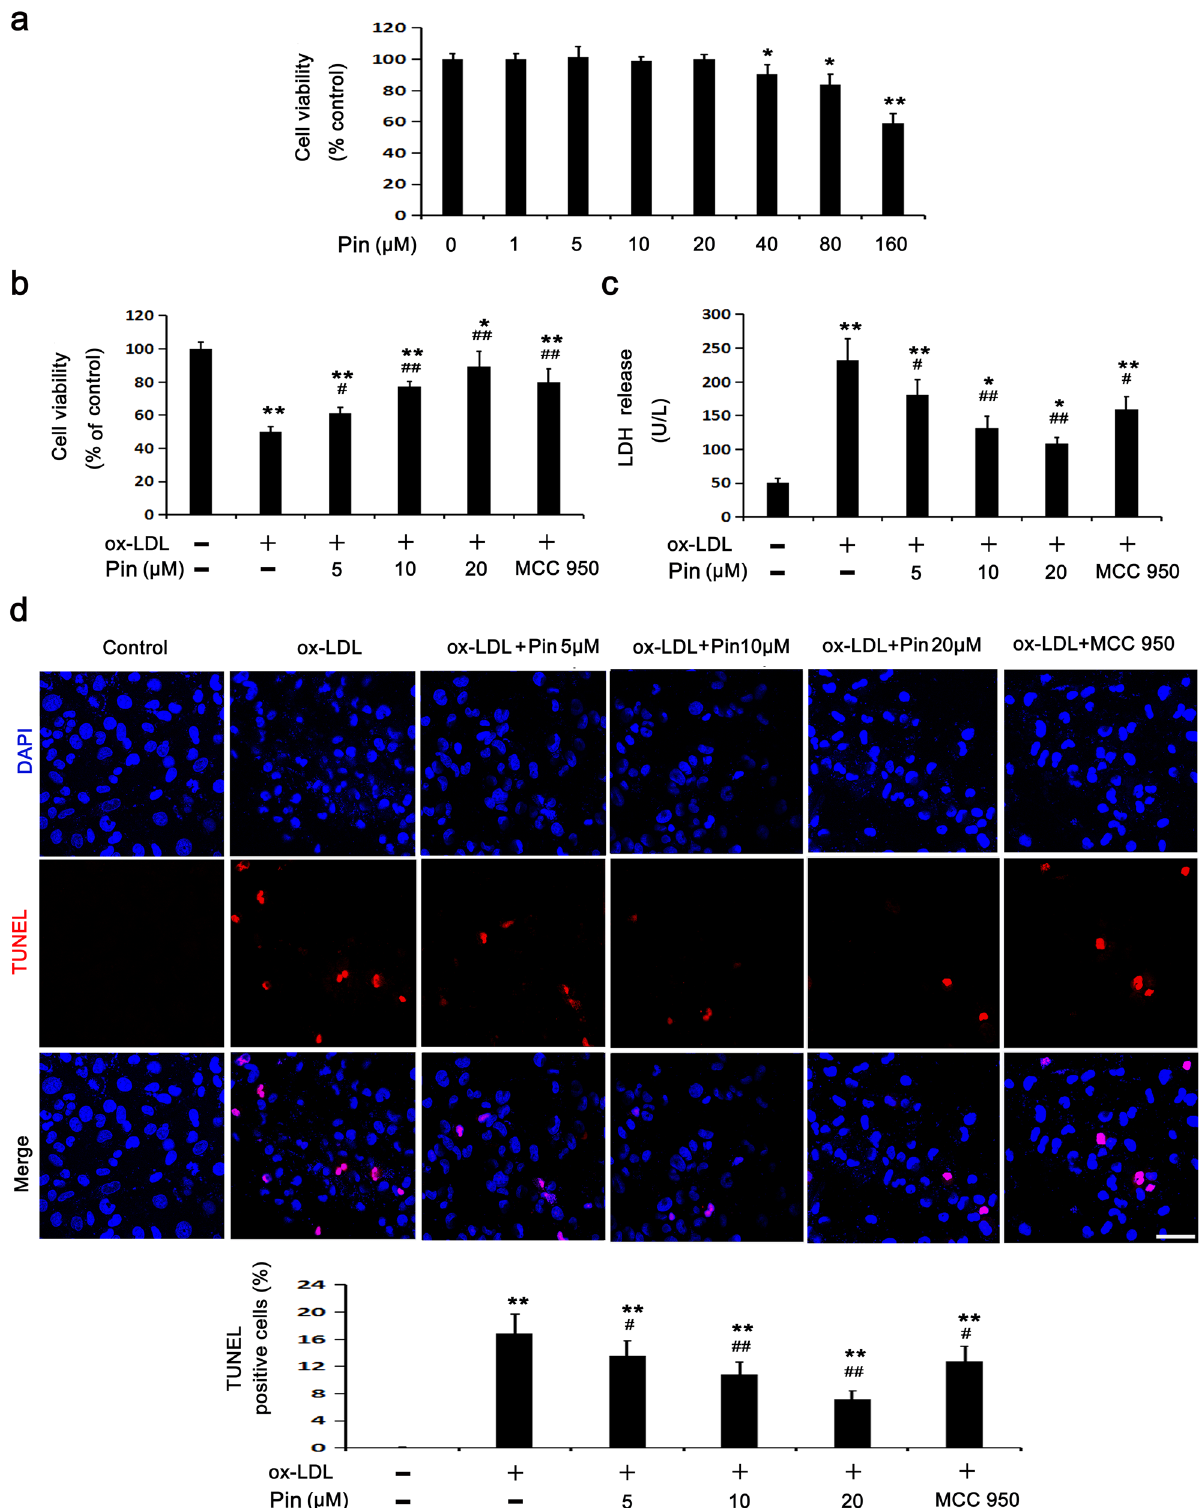
Figure 2. Role of Pin in oxLDL-challenged HUVECs. HUVECs were incubated with Pin (0–160 μM) for 24 h. ( a ) Cell viability was detected through the CCK8 assay. Cells were pretreated with Pin (5, 10, 20 μM) or MCC950 (1 μM) for 2 h before incubated with oxLDL (100 mg/L) for 24 h. CCK8 assay ( b ) and LDH assay ( c ) were adopted to assess cell viability and LDH level in media, respectively. ( d ) TUNEL assay was used to observe cell DNA damage. Red: DNA damaged cells; Blue: DAPI. Quantitative determination of TUNEL-positive cells is shown in the graphs. Scale bar: 50 µm; Data are described with mean ± SD for at least 3 different experiments. * P < 0.05; ** P < 0.01 vs. control cells; # P < 0.05; ## P < 0.01 vs. oxLDL-challenged